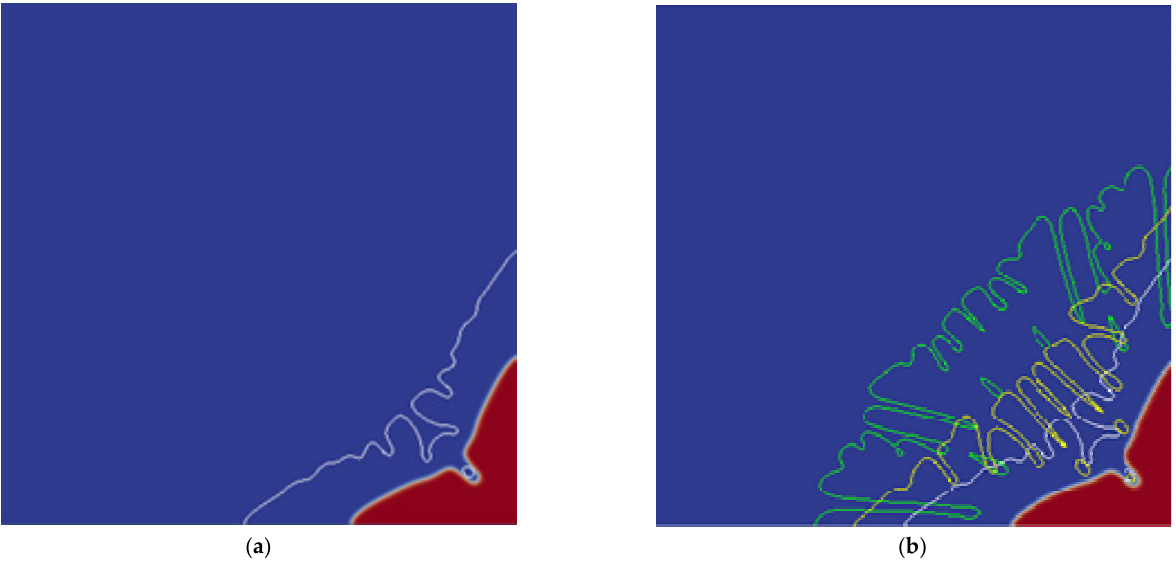
Figure 3. Comparison of the morphology and profile of dendrites at the interface under different supersaturations at a step size of 8000. ( a ) Comparison of supersaturation 0.35 and 0.45; ( b ) Comparison of supersaturation 0.35, 0.45, 0.50, and 0.55. Where red is 0.35, white is 0.45, yellow is 0.50, and green is 0.55.